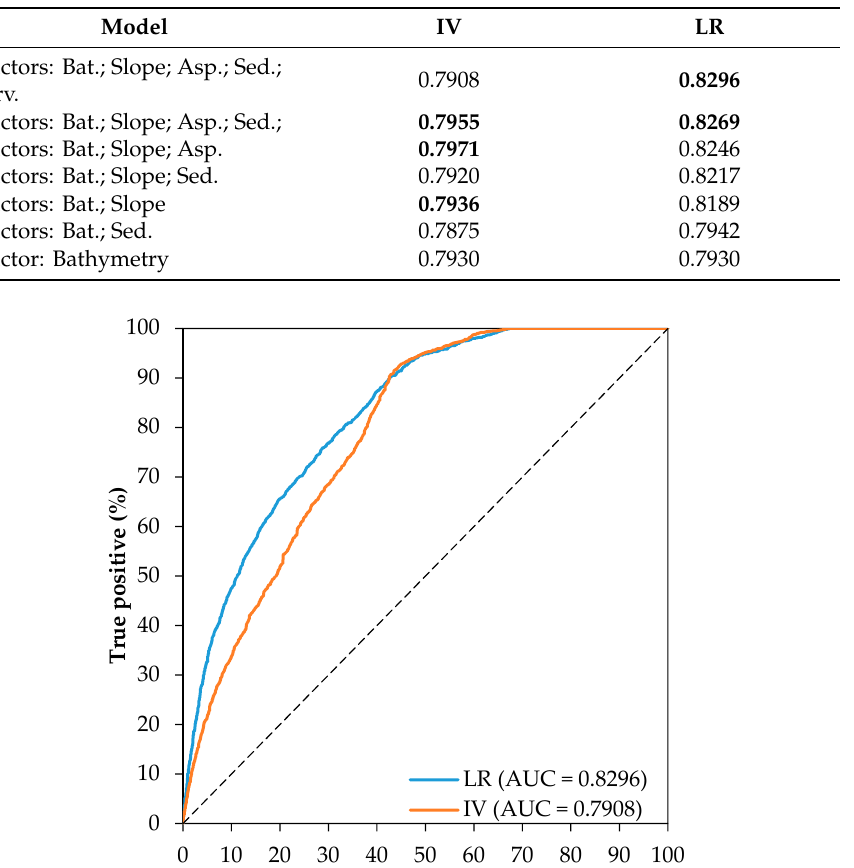
Table 4. Receiver operating characteristic (ROC) curves area under the curve (AUC) values for the different models produced with 1 to 5 predisposing factors, according to their relevance. Models computed with the information value (IV) and logistic regression (LR) methods. Higher values are highlighted in bold.